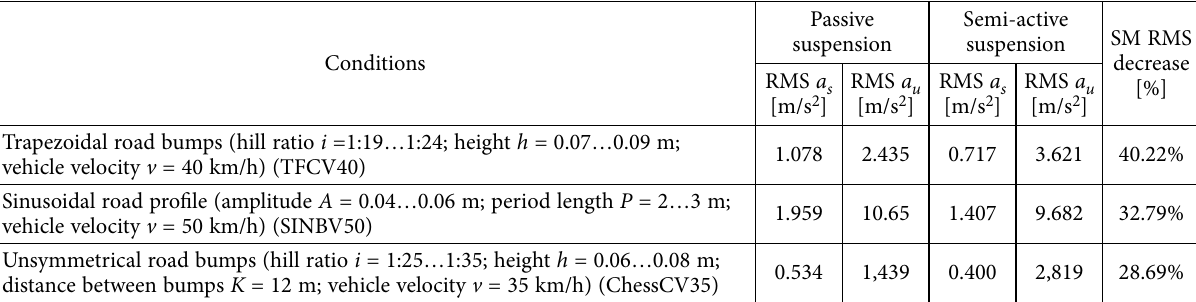
Table 2. Comparison of reference passive suspension and semi-active suspension